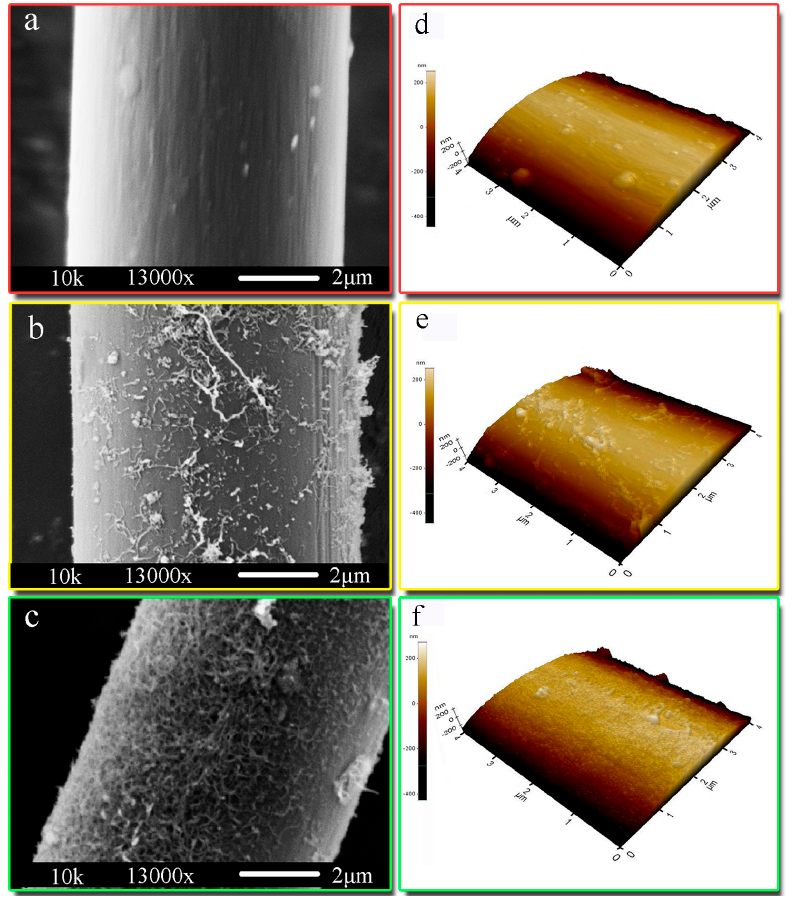
Figure 3. Scanning electron microscopy (SEM) and atomic force microscopy (AFM) images of carbon fiber ( a , d ) desized; ( b , e ) CNTs deposited without ultrasonic; ( c , f ) CNTs deposited with ultrasonic.